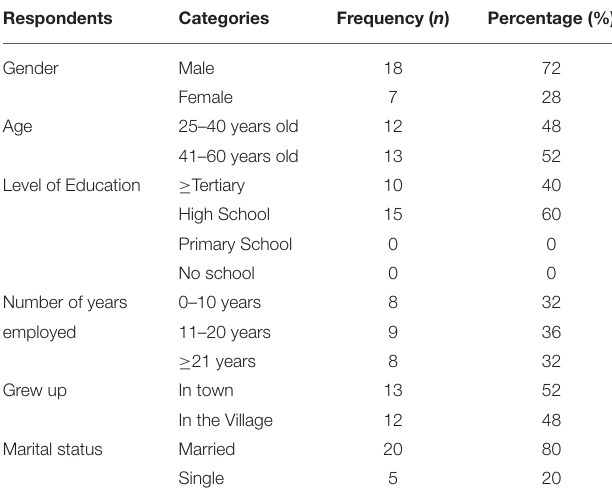
TABLE 1 | Profile of law enforcement officer respondents ( n =